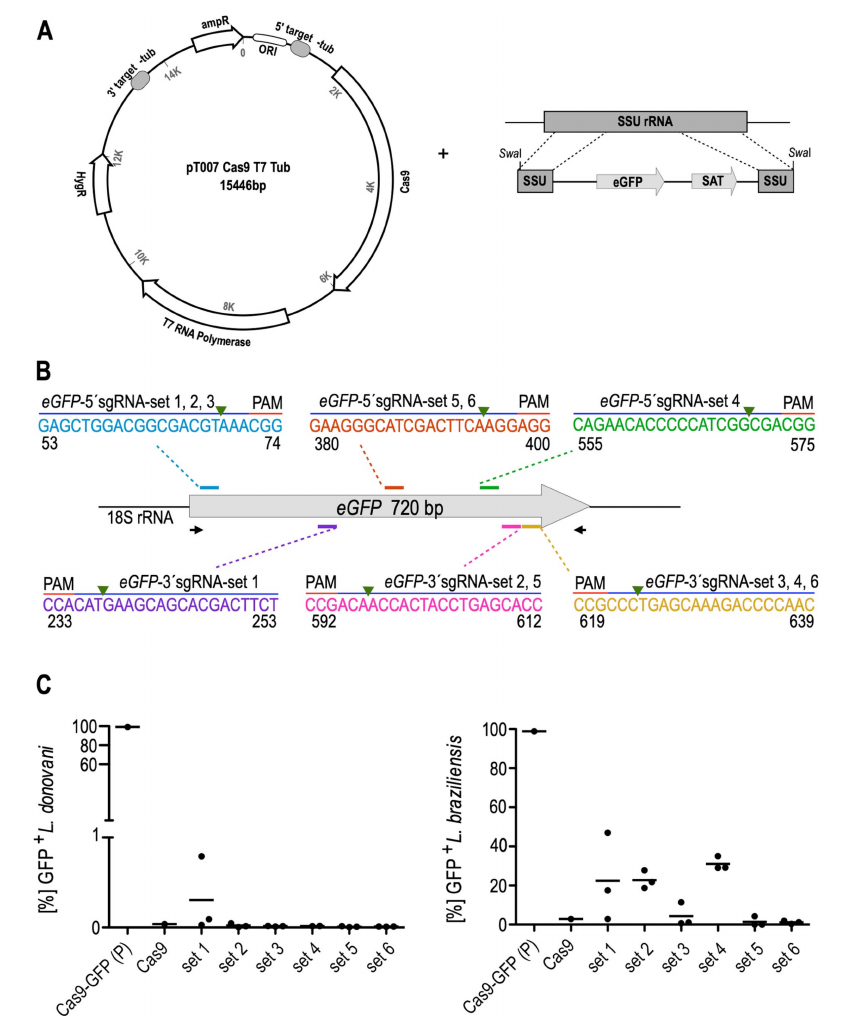
Figure 1. CRISPR–Cas9-mediated disruption of eGFP gene as proof-of-principle test in L. braziliensis . ( A ) Generation of Cas9–eGFP-expressing parasites. Left panel : plasmid pTB007 [17] bearing hSpCas9 and T7 RNAP transgenes was transfected as circular episome into L. braziliensis PER005cl2 wild-type parasites. Transfectants were selected under Hygromycin B pressure. Right panel : schematic depiction of the double cross-over homologous recombination strategy to integrate the linearised pIR– eGFP construct into the SSU rRNA locus of L. braziliensis Cas9-expressing parasites. Regions shown are the SSU rRNA sequences on either ends resulting from Swa I restriction digest, the eGFP ORF, and the nourseothricine resistance gene ORF ( SAT , encoding streptothricin-acetyltransferase). ( B ) Schematic representation of the eGFP locus and locations of the six 20-nt guide RNA sequences used for gene disruption; the guide sequence pairs with the DNA target (blue bar), directly upstream of a requisite 5’-NGG-3’ adjacent motif (PAM). The green arrowhead indicates the predicted Cas9 cleavage sites. Only the coding strand is shown. Binding sites of primers used for genotyping of genetically engineered parasites are denoted by arrows. The PCR fragment size depended on the pair of single guide RNAs (sgRNAs) tested. Sets of sgRNAs tested: set 1 = eGFP -52-5’sgRNA and eGFP -253-3’sgRNA; set 2 = eGFP -52-5’sgRNA and eGFP -612-3’sgRNA; set 3 = eGFP -52-5’sgRNA and eGFP -639-3’sgRNA; set 4 = eGFP -553-5’sgRNA and eGFP -639-3’sgRNA; set 5 = eGFP -378-5’sgRNA and eGFP -612-3’sgRNA; set 6 = eGFP -378-5’sgRNA and eGFP -639-3’sgRNA. ( C ) Flow cytometry analysis of eGFP–Cas9-expressing parasites before and after transfection of eGFP -targeting sgRNAs. E ffi ciency of eGFP disruption using 6 di ff erent sets of sgRNAs in L. donovani (left panel) and L. braziliensis (right panel) as quantified by GFP expression. Each set of two sgRNAs was co-transfected with two donor DNAs; transfections were done in triplicate. Sets of sgRNAs tested (labelled as set 1 to 6 in the graphs) consisted of pairs as described in Figure 1B. P, parental cell line Cas9 / T7 / eGFP. The gating scheme, a representative histogram, and all FACS plots showing the percentage of GFP-positive cells are shown in Supplemental Figures S2 and